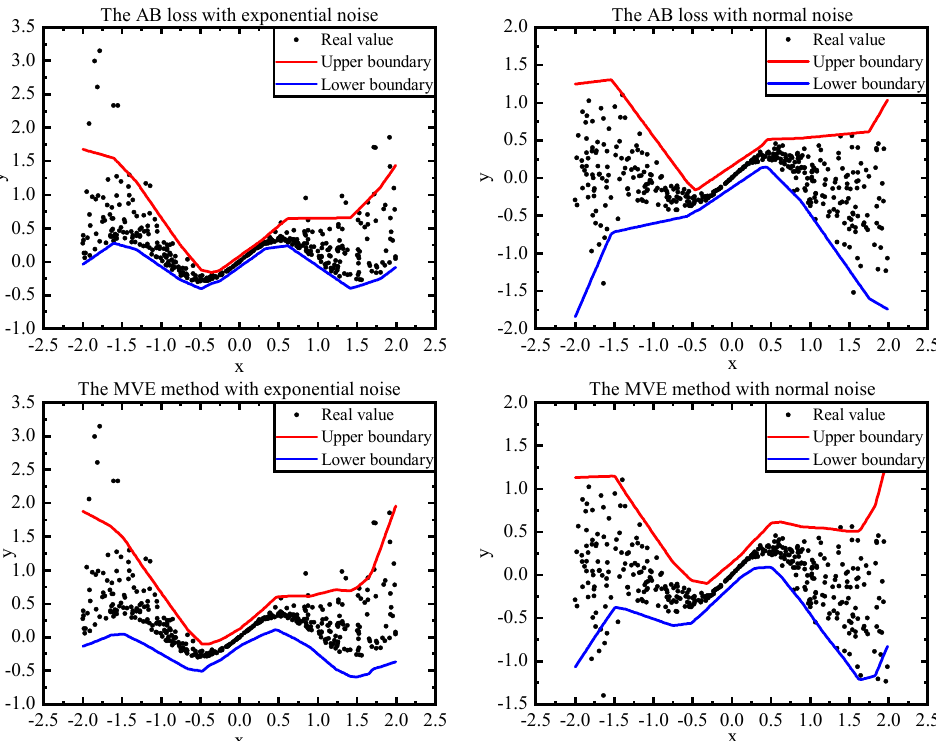
Figure 4. Comparison of PI boundaries for the MVE method and the AB loss under normal noise and exponential noise. The upper and lower boundaries are the predicted 95% PIs.